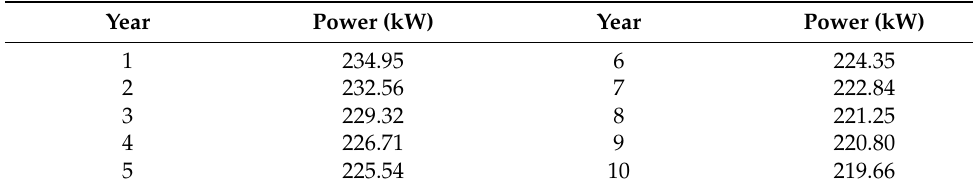
Table 3. Theoretical output power change of